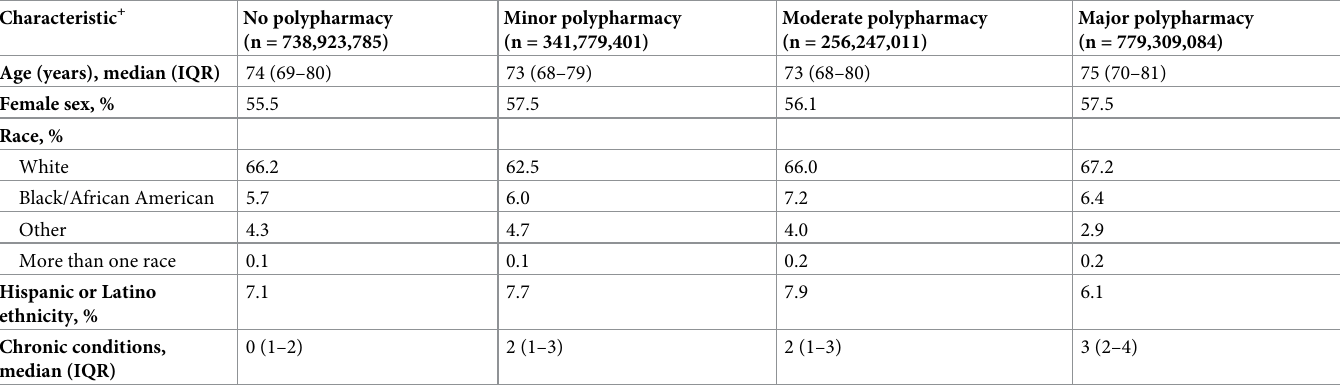
Table 1. Baseline characteristics by degree of